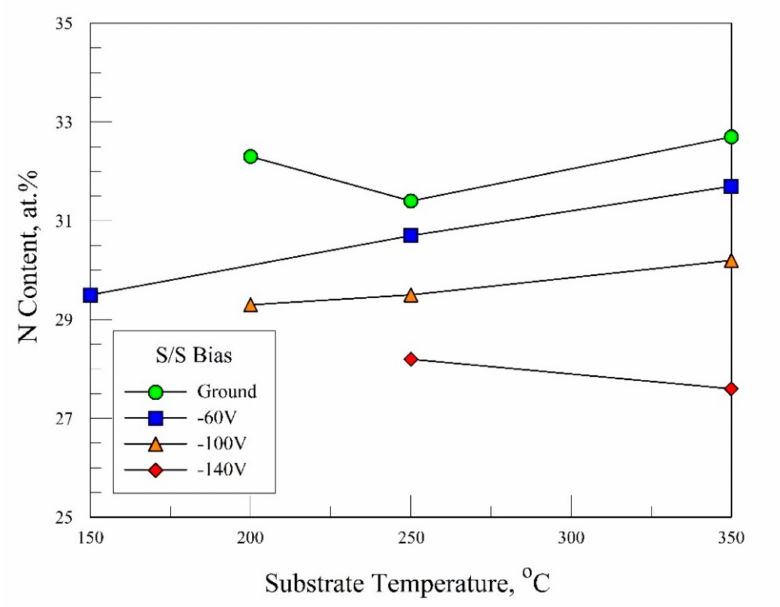
Figure 2. Nitrogen concentration in films deposited at di ff erent substrate temperature and bias levels. The major e ff ect on composition is due to changes in substrate